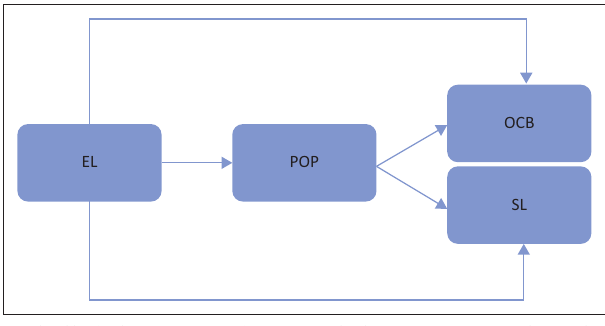
FIGURE 1: Theoretical